Question: Identify the chart type used in this figure.
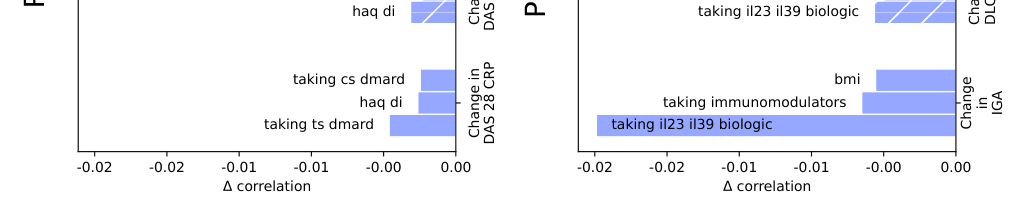
Answer: bar